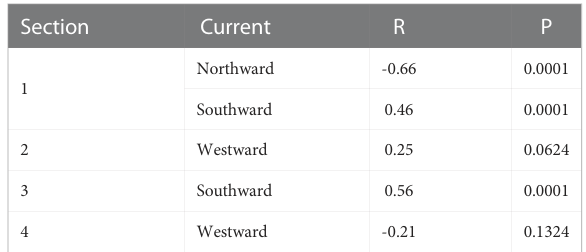
TABLE 3 Results of linear regression analysis between Q T and SST